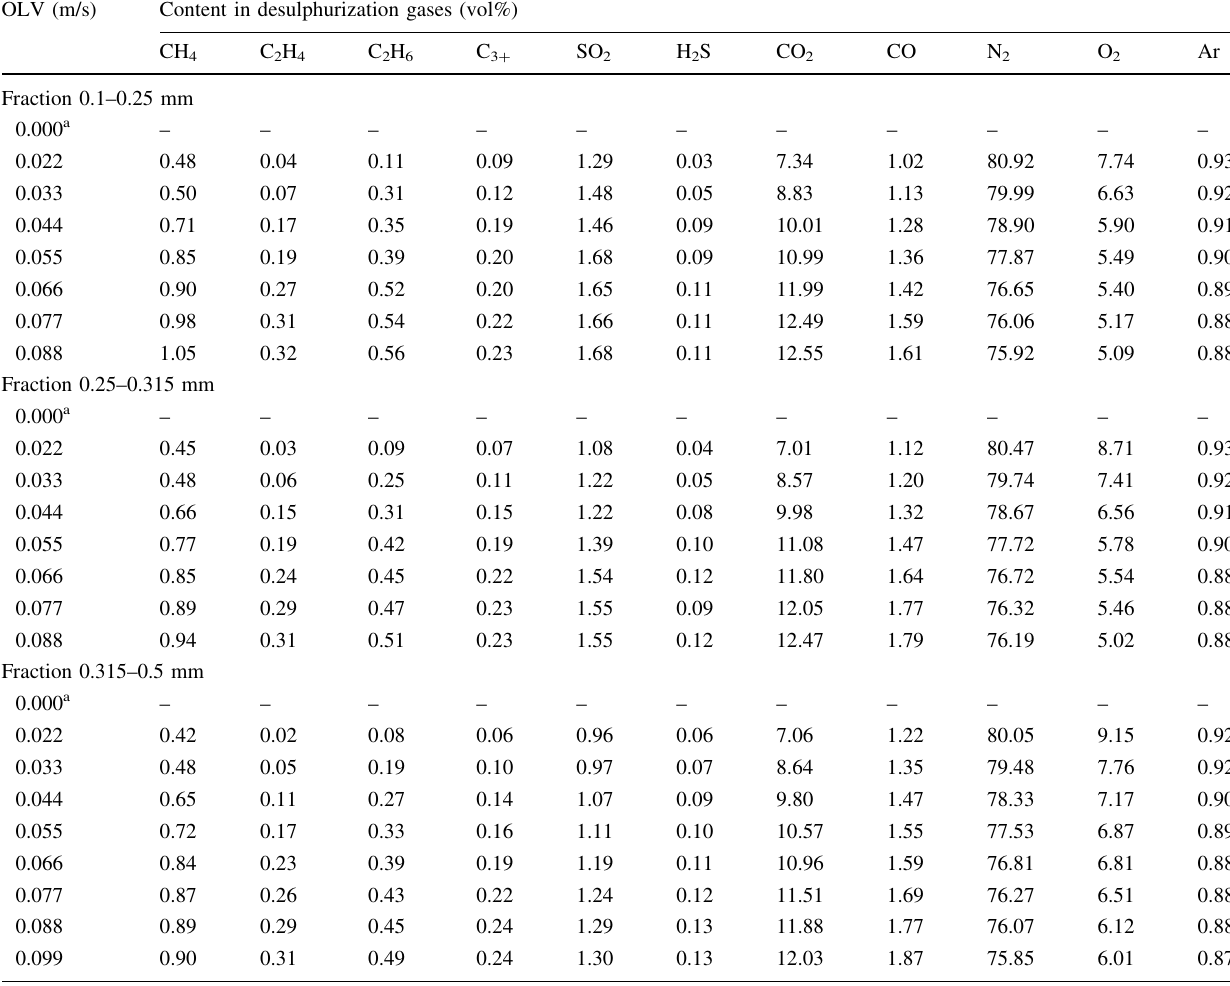
Table 9 Desulphurization gases composition OLV (m/s) Content in desulphurization gases